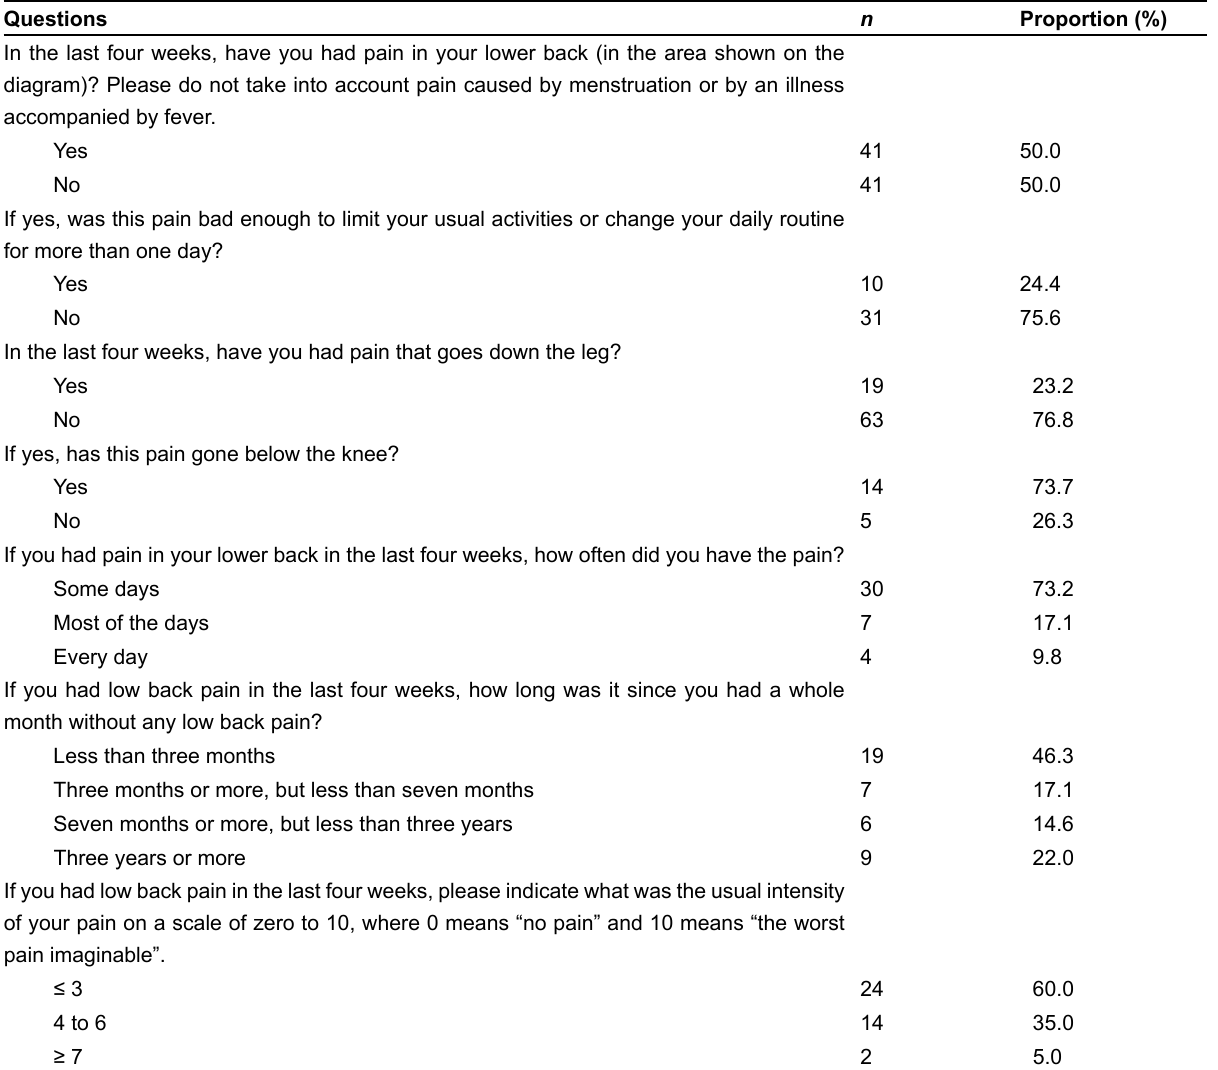
Table 3. Participants’ answers to the Delphi DOLBaPP questionnaire